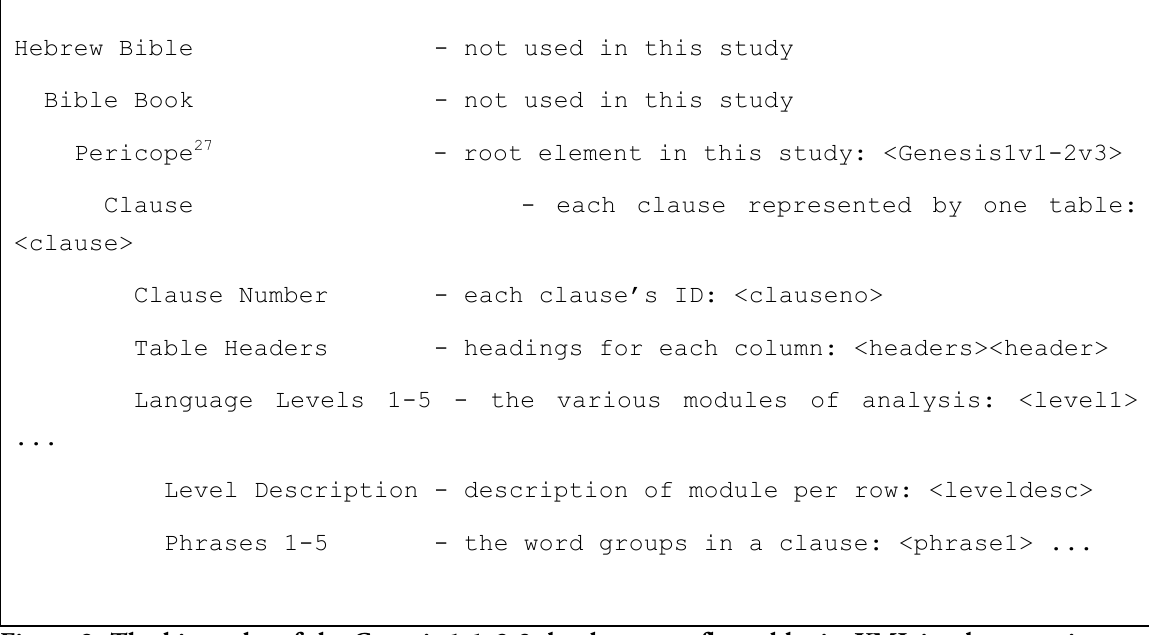
Figure 2. The hierarchy of the Genesis 1:1-2:3 database as reflected by its XML implementation. This hierarchy actually represents various levels and layers. Although other documents could be used to mark up other versions of analyses and the various documents connected by means of